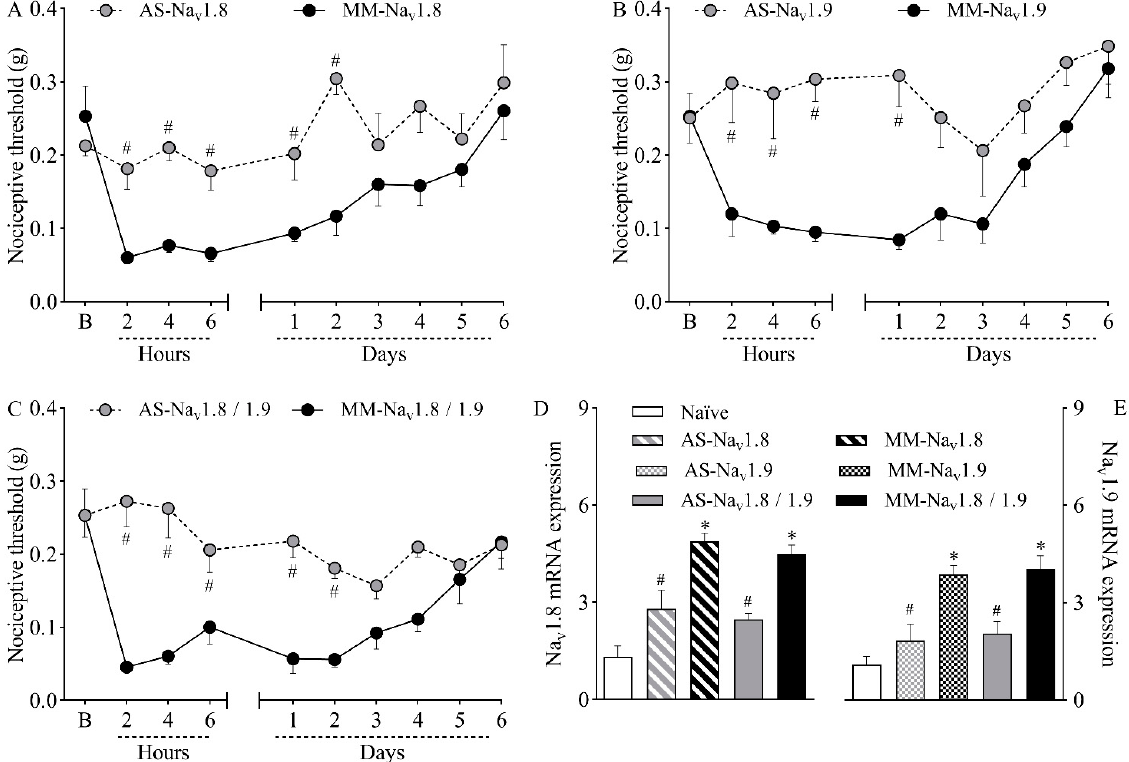
Figure 2. Mice were treated intrathecally with antisense oligodeoxynucleotide targeting Na v 1.8 (AS-Na v 1.8), Na v 1.9 (AS-Na v 1.9), both antisense treatments combined (AS-Na v 1.8/1.9), mismatch oligodeoxynucleotide targeting Na v 1.8 (MM-Na v 1.8), Na v 1.9 (MM-Na v 1.9), or both mismatches combined (MM-Na v 1.8/1.9). Mice were treated once a day (10 µ g in 5 µ L) for four days (final dose of 40 µ g) and then induced to the plantar incision model of postoperative pain one hour after the last treatment. No treatments or surgical procedures were performed on naïve mice. ( A – C ) The mechanical nociceptive threshold (axis of ordinates) was evaluated at baseline ( B ) and at different times in hours and days after plantar incision (axis of abscissas). Values represent the filament weight (g) to which mice respond in 50% of presentations. Data are expressed as means ± SD ( n = 6). # p < 0.05 compared with the respective mismatch group. Two-way ANOVA followed by Bonferroni’s test. ( D , E ) The levels of Na v 1.8 and Na v 1.9 mRNA in the DRG (axis of ordinates) were determined by Real-Time PCR two days after plantar incision. Target gene expression (2 − ∆∆ Ct ) was determined using Gapdh as housekeeping gene. Data are expressed as means ± SD ( n = 6). * p < 0.05 compared with naïve group. # p < 0.05 compared with the respective mismatch group. One-way ANOVA followed by Tukey’s